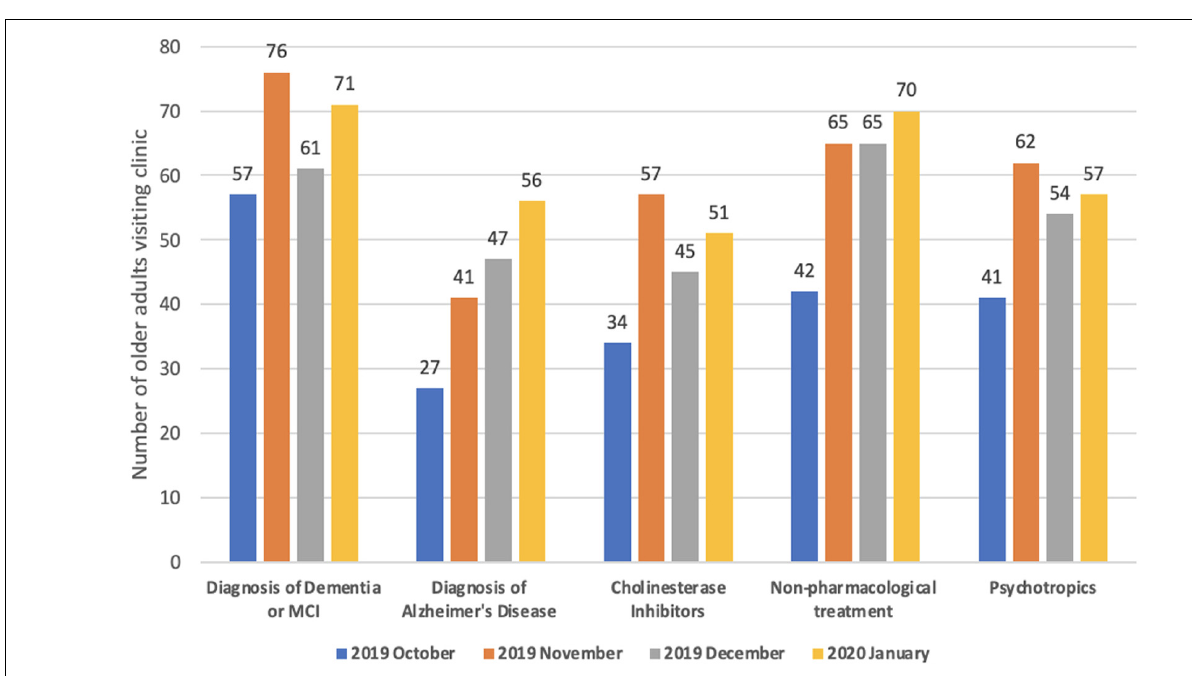
FIGURE 2 | Clinical profile of patients with dementia visiting physician’s clinic–Monthly aggregate of all participants